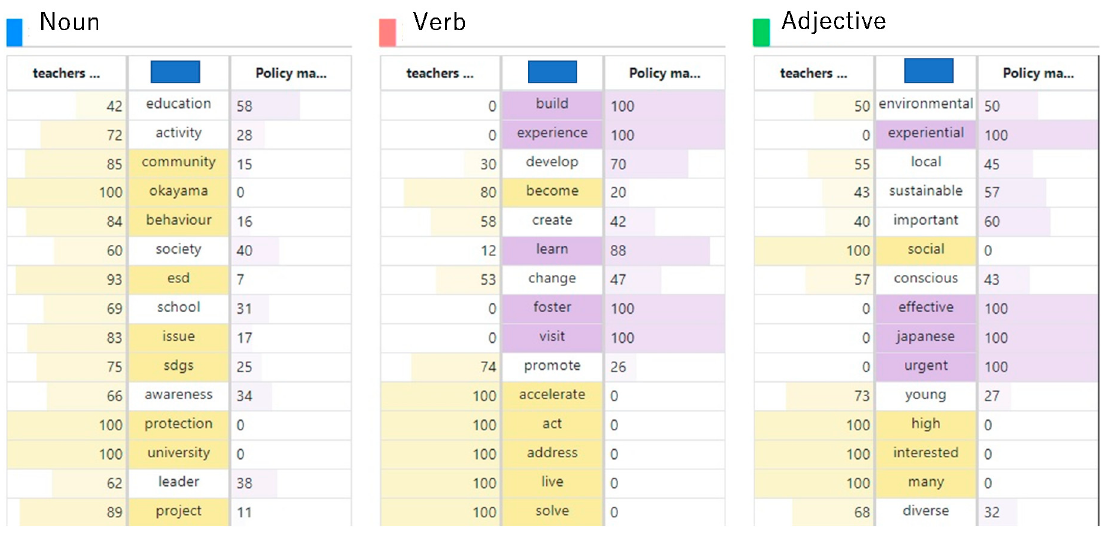
Figure 9. Comparative word analysis for two groups.